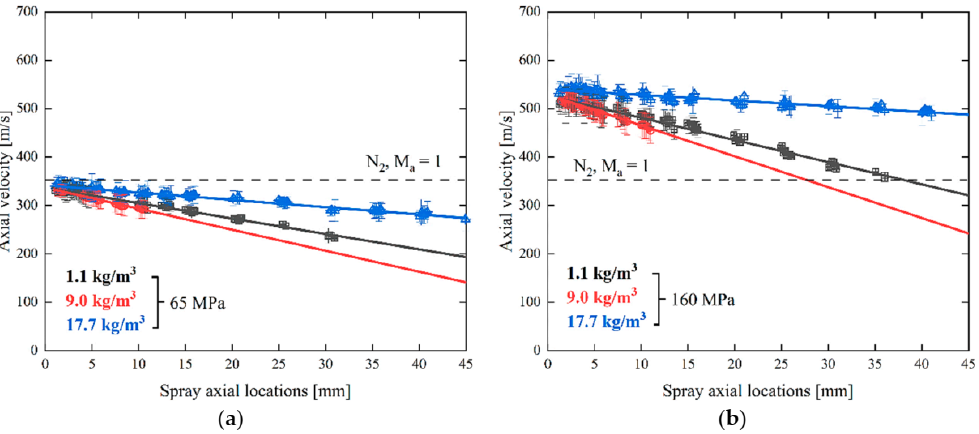
Figure7. Sprayaxialvelocitiesundervariousambientdensities. ( a ): 65MPa; ( b ): 160MPa. (Ambientgas condition: N 2 and 297 K; Local sound speed: 352 m /